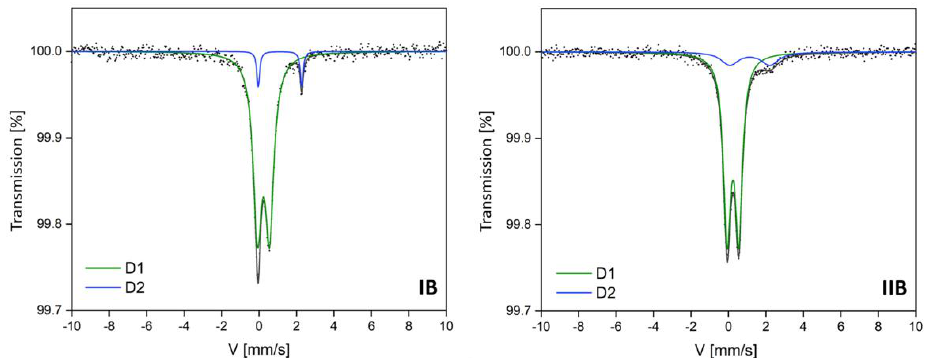
Figure 2. The room temperature Mössbauer spectra of the topsoil subsamples (IA, IIA, IB, IIB). Fitted components are presented on the figure as D1, D2, Z1, Z2, Z3. The x -axis of these charts represents velocity (V), while the y -axis represents transmission (%). G—full width at half maximum = (0.35–0.40) mm/s .